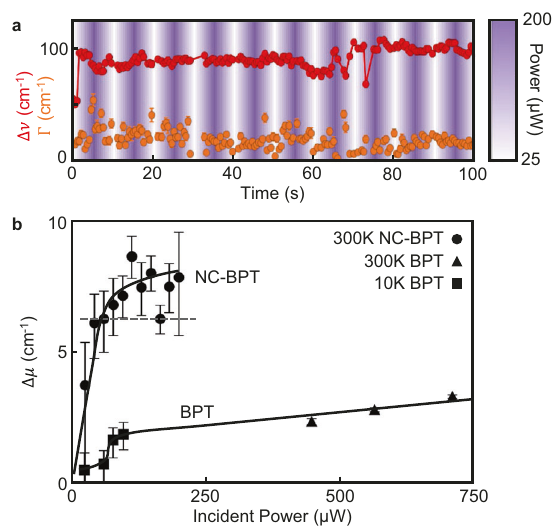
Fig. 4 Spectral dynamics power dependence. a Full linewidth ( Γ ) and downshift 4 ν ð Þ of perturbed NC-BPT CN picocavity peak as incident laser power is cycled between 25 and 200 µ W (shading). Neither width nor spectral wandering shows signi fi cant power dependence. b Effective extent of spectral fl uctuations ð4 μ Þ for CN vibration of NC-BPT, BPT picocavity at 10 K, and aggregated picocavities from 106 BPT NPoMs at 300 K (for BPT picocavity lines ~1500 cm − 1 ). Error bars indicate standard error. Estimated contribution from 300 K thermal adatom motion along the d NAu coordinate for NC-BPT shown as dashed